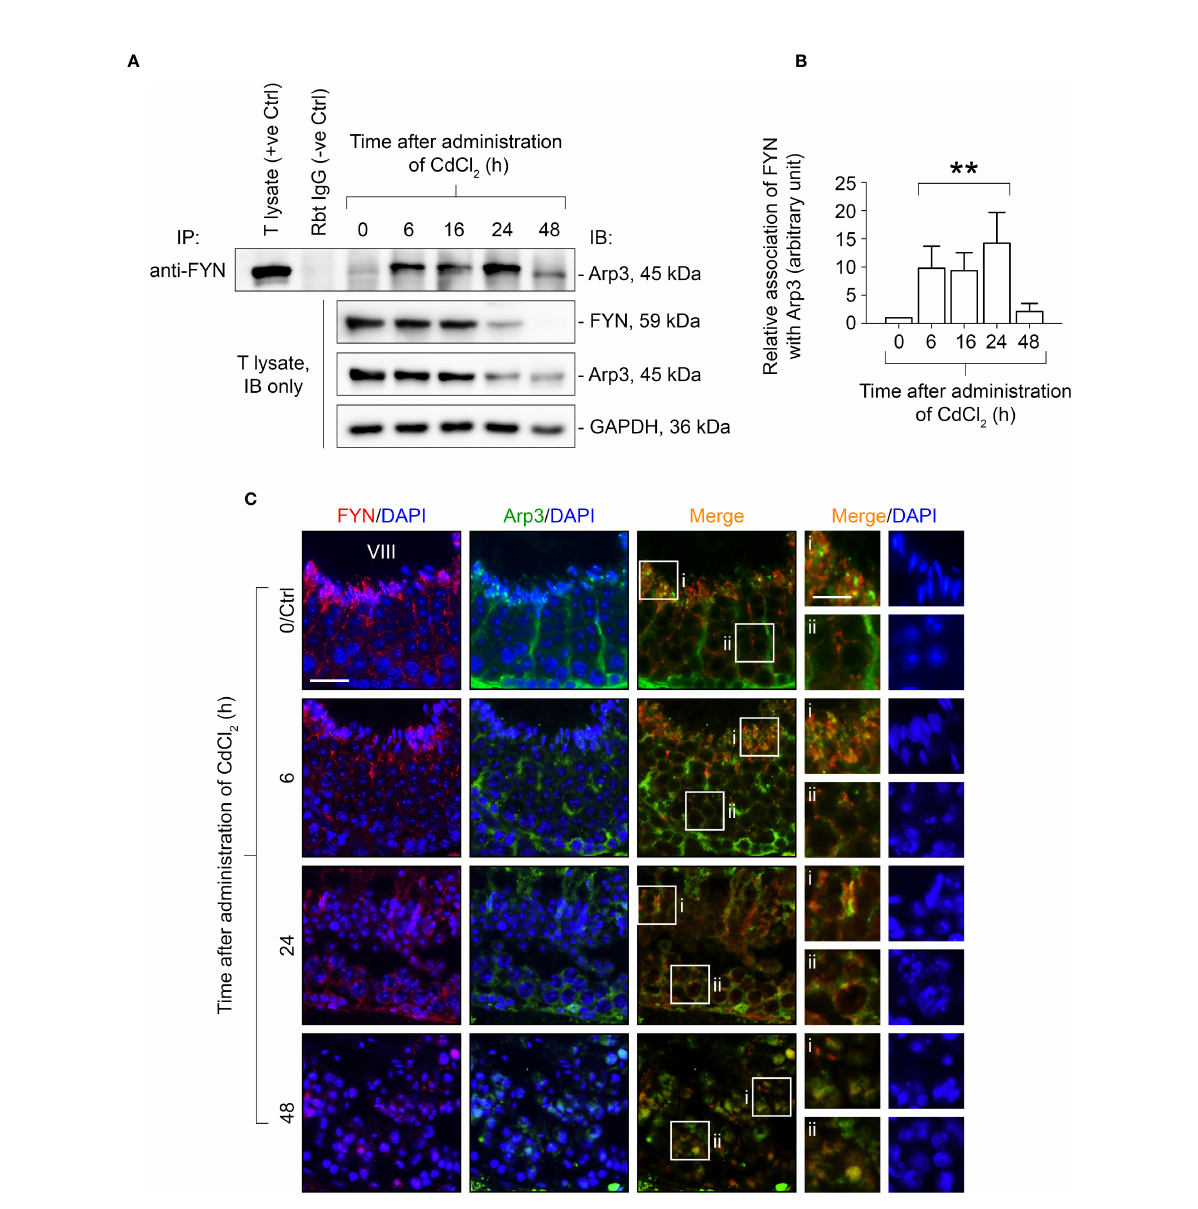
FIGURE 5 Co-immunoprecipitation (Co-IP) study to evaluate changes in protein-protein interactions between FYN and Arp3 during CdCl 2 -induced junctional restructuring (A) . For Co-IP experiments, ~800 µg testis (T) lysate from CdCl 2 -untreated and treated mice was incubated with anti- FYN IgG, followed by immunoblotting (IB) with an Arp3 antibody (Table 1). Also shown was the change in FYN and Arp3 protein levels in response to CdCl 2 administration. GAPDH served as an internal control. (B) A histogram summarizing the results of Co-IP. FYN association with Arp3 at 0 hour was arbitrarily set at 1. Each bar represents the mean ± S.D. of three independent experiments. **P<0.01 by one-way ANOVA with Dunnett ’ s test. (C) Dual-labeled IF experiments to evaluate how FYN and Arp3 co-localization changed in the seminiferous epithelium following CdCl 2 administration. As of time 0/Ctrl, the epithelial cycle of the seminiferous tubule was clearly identi fi ed as stage VIII, which is given in Roman numerals. After 24 hours, the seminiferous epithelium had collapsed and it was impossible to determine its stage. The boxes denoted with i or ii in the third column (Merge) are magni fi ed in the fourth column and their corresponding DAPI shown on the right ( fi fth column). Bar = 20 m m ( fi rst column, also applies to second and third columns); bar (magni fi ed views in the fourth and fi fth columns) = 10 m